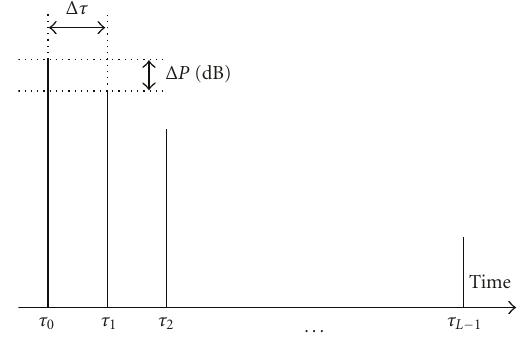
Figure 3: Channel model with exponential decay